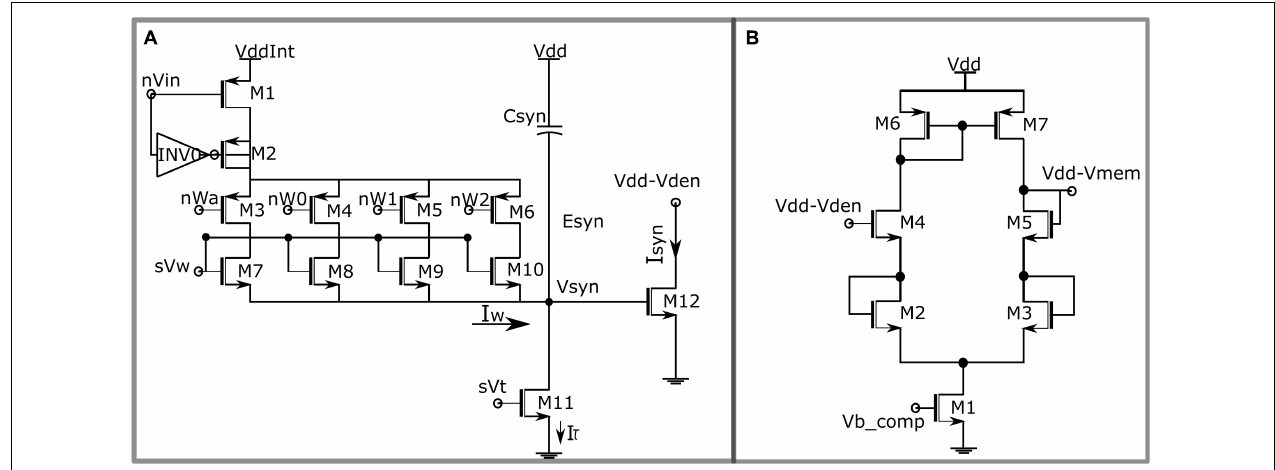
FIGURE 3 | (A) Circuit diagram of the synaptic circuit. Dimensions of the transistors: M7 = 0.3758 * (w/l), M8 = w/l, M9 = 2 * (w/l) and M10 = 4 * (w/l) with w = 2 µ m, l = 500 nm. (B) Single-stage source degenerated transconductance amplifier configured as unidirectional